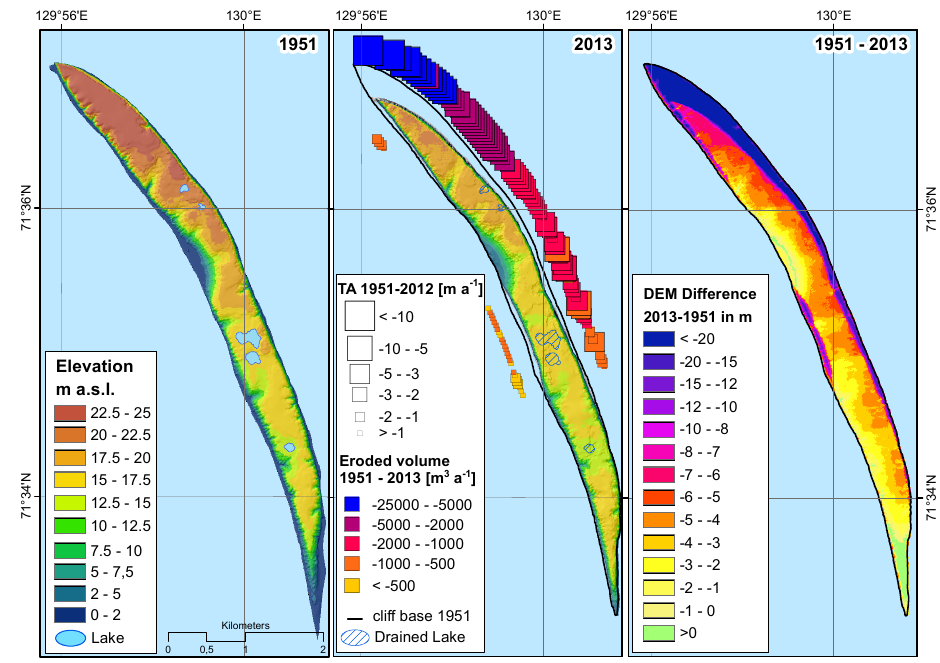
Figure 9. Left: DEM from 1951 stereoscopic aerial photography. Middle: DEM from 2013 GeoEye stereo pair. Symbol size is the classified planimetric coastal erosion rate. Colour-code displays volumetric erosion from 1951 until 2010 for 118 coastline segments. Right: difference raster from multitemporal DEMs representing elevation changes over 62 years.